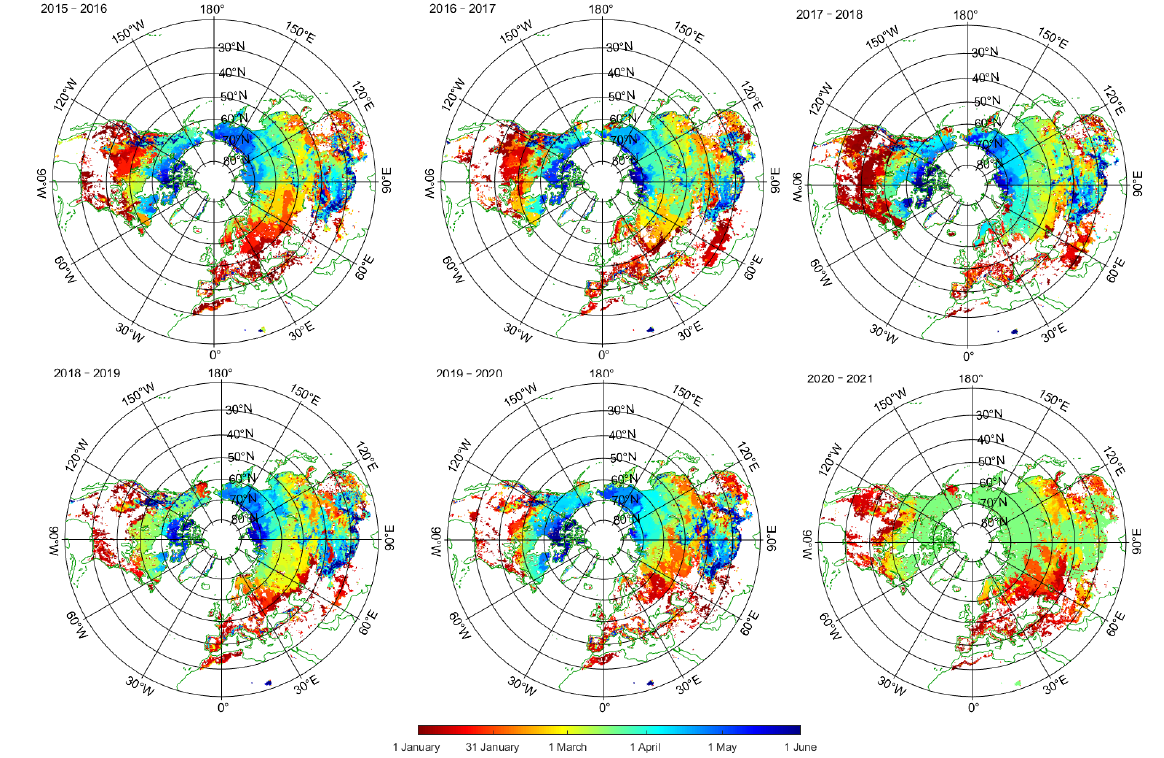
Remote Sens. 2022 , 14 , 4747 Figure 6. The ending of the frozen-soil periods of the six winters as inferred by the new FT algorithm.